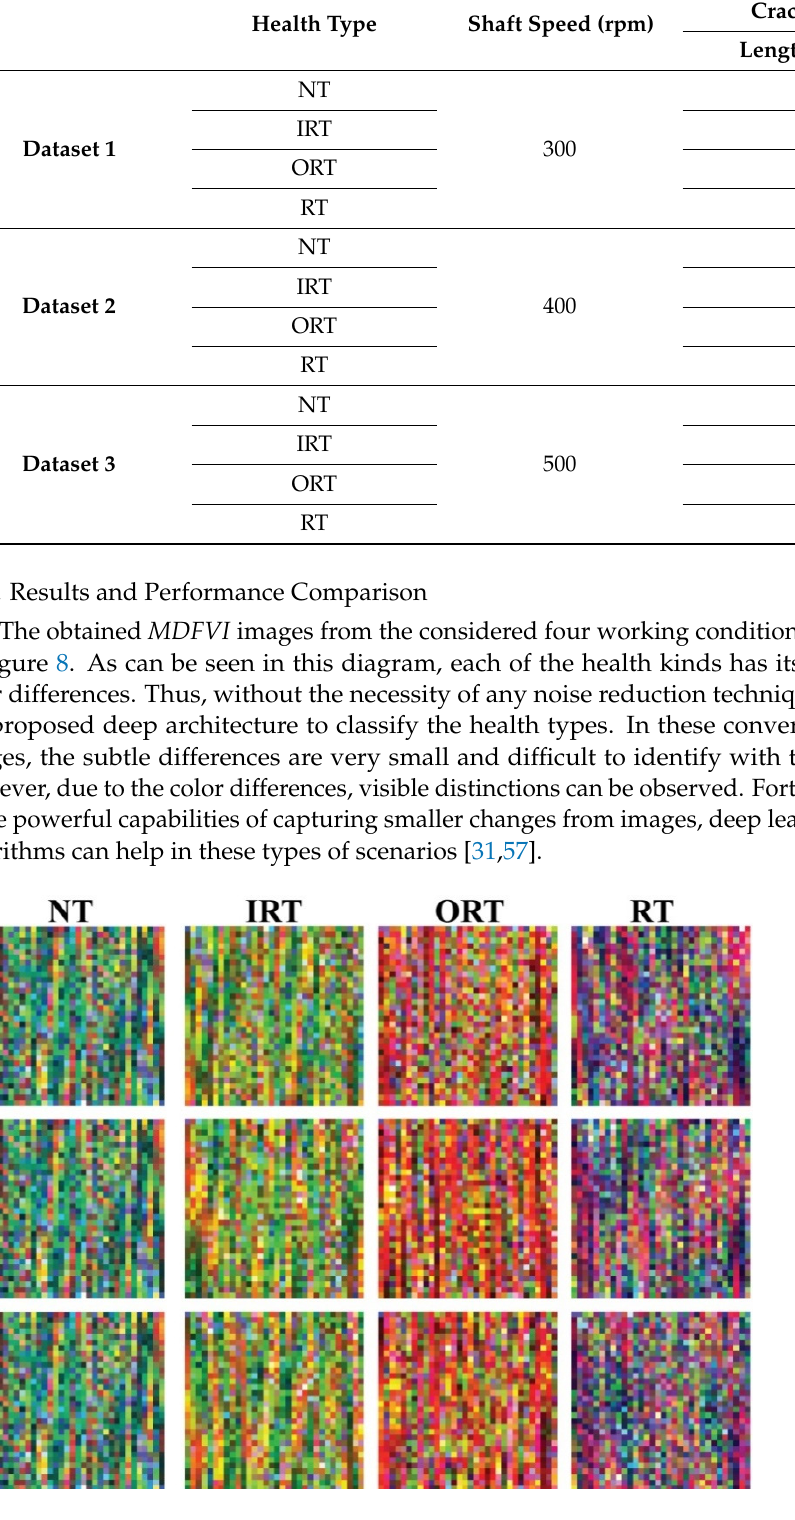
Figure 8. MDFVI representation of various health types at different speeds: NT, IRT, ORT, and RT.